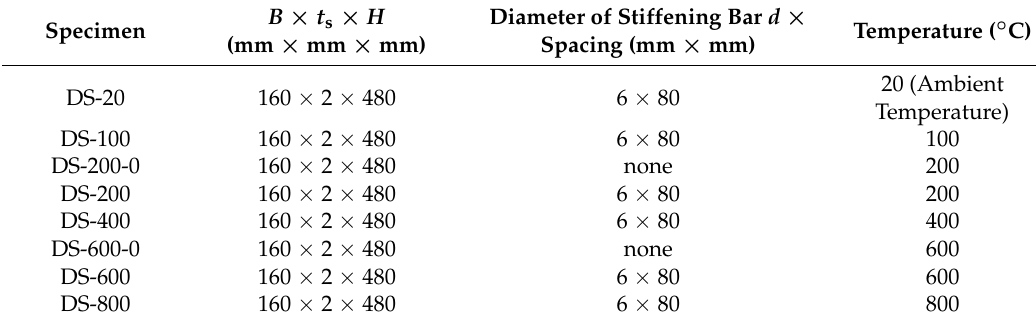
Table 1. Main parameters of